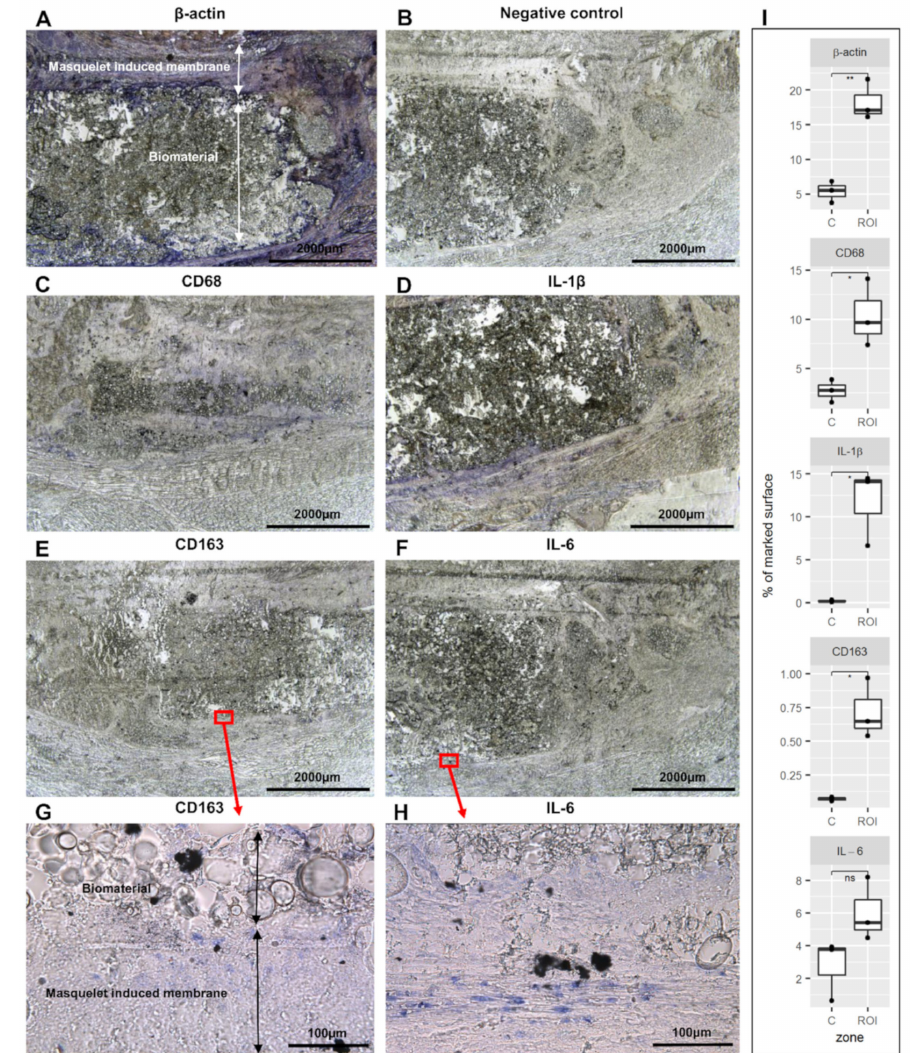
Figure 9. In situ hybridization in the operated rat femur: ( A ) expression of β -actin mRNA (positive control); ( B ) negative control; ( C ) CD68 mRNA; ( D ) IL-1 β mRNA; ( E ) CD163 mRNA; ( F ) IL-6 mRNA; ( G ) expanded view: high magnification image of the area within the red rectangle in image ( E ); ( H ) expanded view: high magnification image of the area within the red rectangle in image ( F ); ( I ) the stained area of the picture was quantitatively analyzed using ImageJ. The Masquelet induced membrane region was compared with the control region ( C ) (n = 3). ** p < 0.01, * p < 0.5, ns = not significant, compared to control